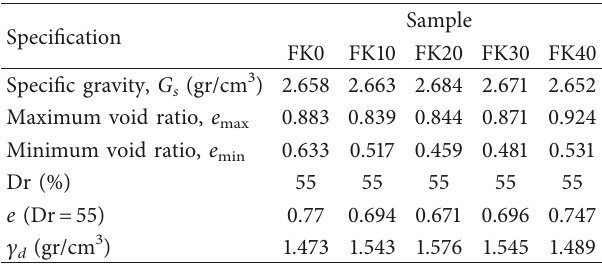
Table 3: Density properties of samples.